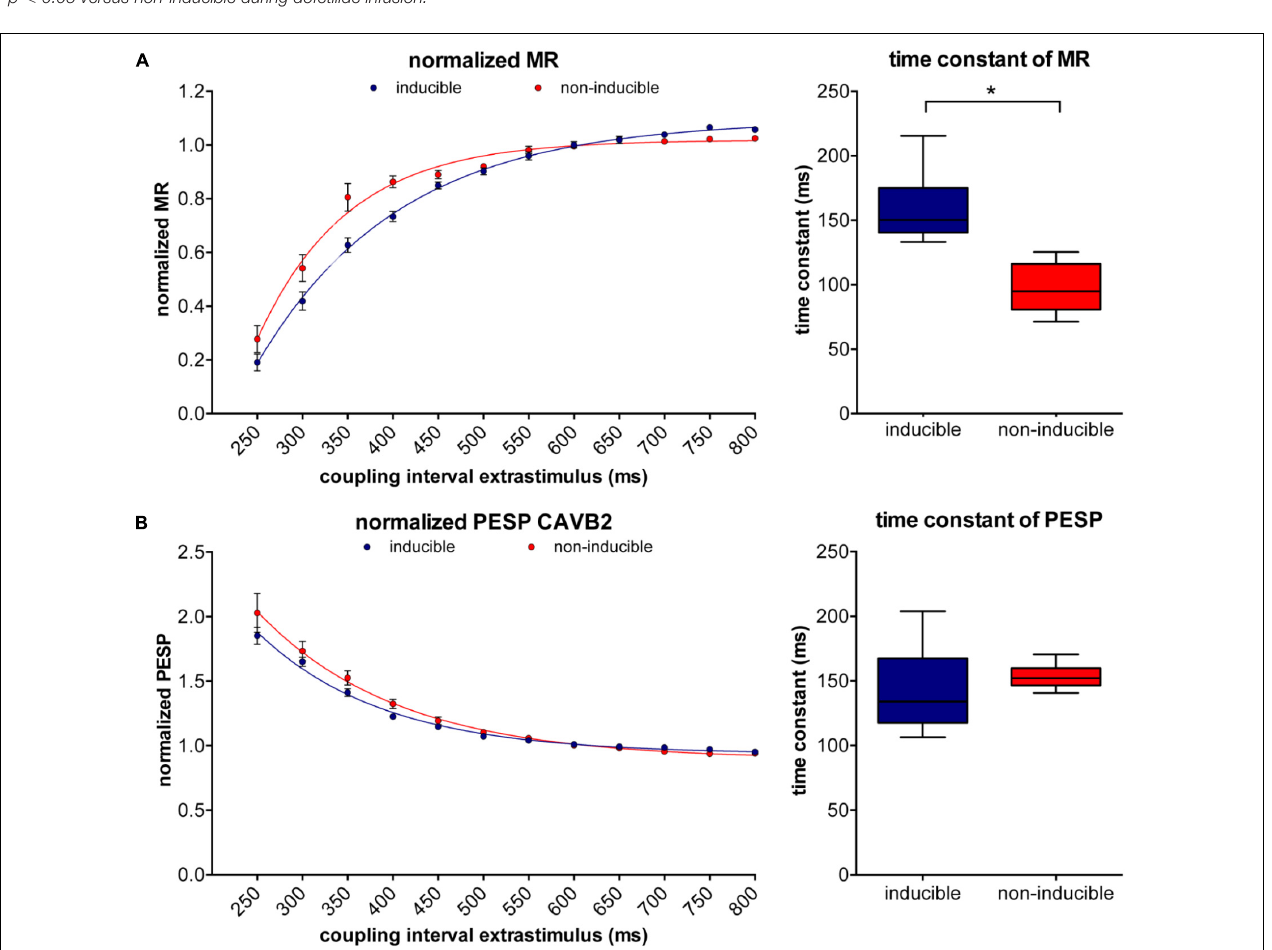
FIGURE 4 | Normalized MR and PESP curves of inducible and non-inducible dogs. (A) The inducible dogs show slower restitution compared to the non-inducible dogs (left) with significantly higher time constants (TCs; right). (B) Normalized PESP curves are similar in inducible dogs and non-inducible dogs. ∗ p <